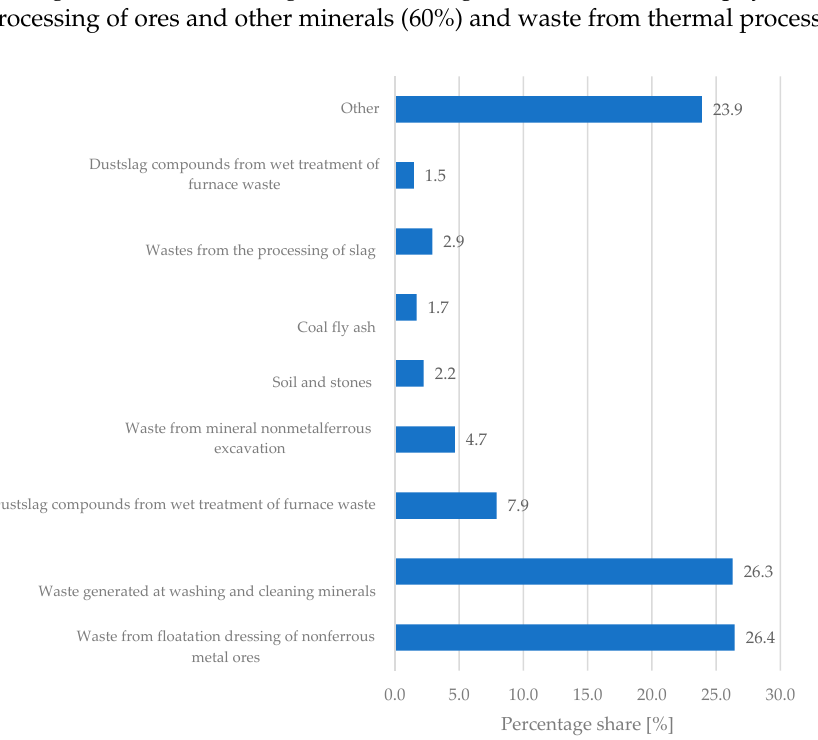
Figure 3. Structure of waste (excluding municipal waste) generated in Poland in 2019. Source: own based on [42].